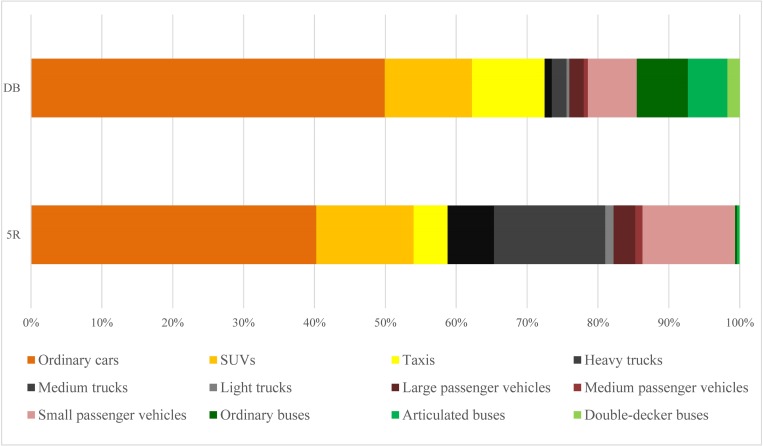
Structural characteristics of the traffic CO2 emissions at 5R and DB.